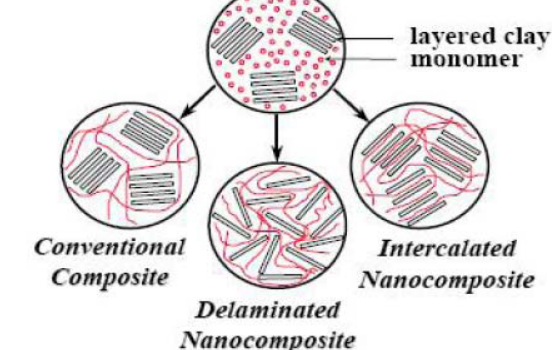
Fig. 1. Three configurations of polymer/clay composites